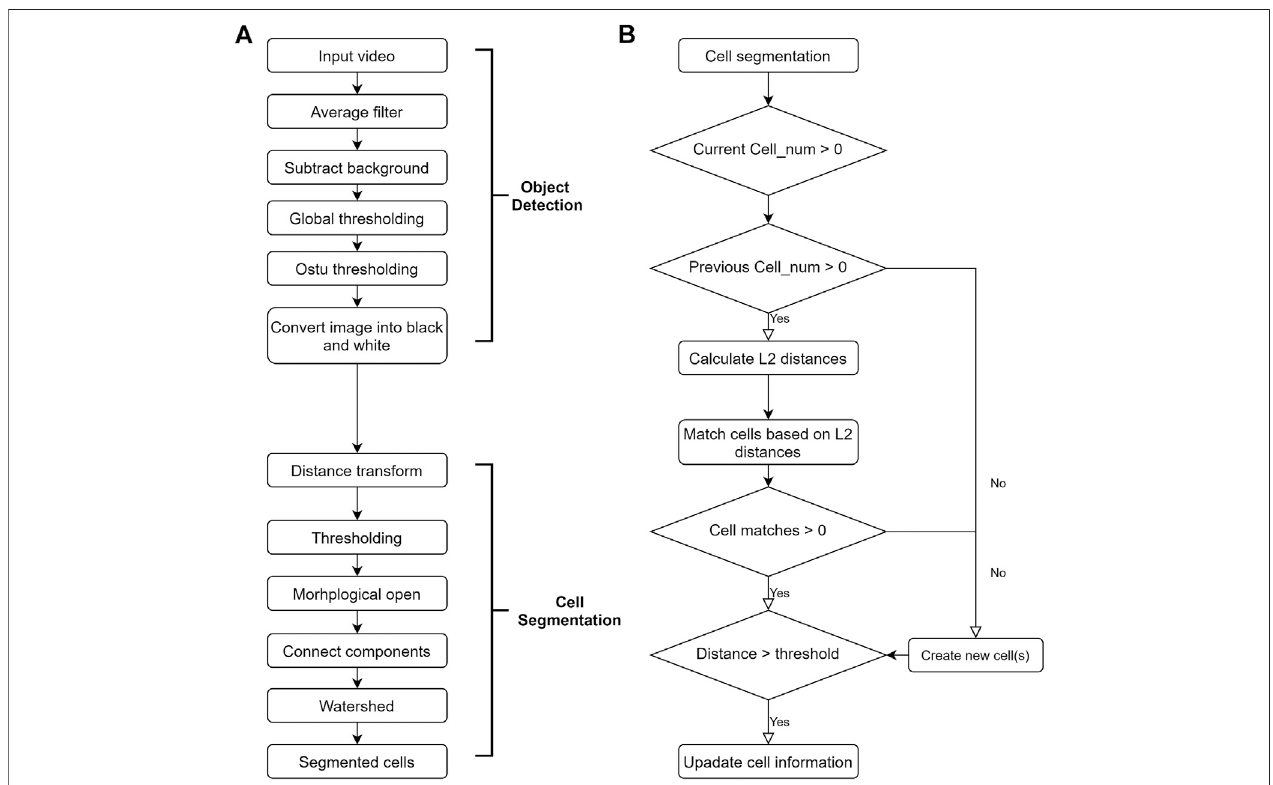
FIGURE 2 | Flow chart of video processing algorithm. (A) Flow chart of the individual frame analysis. This can be further divided into object detection and cell segmentation. (B) Flow chart of the cell matching algorithm.